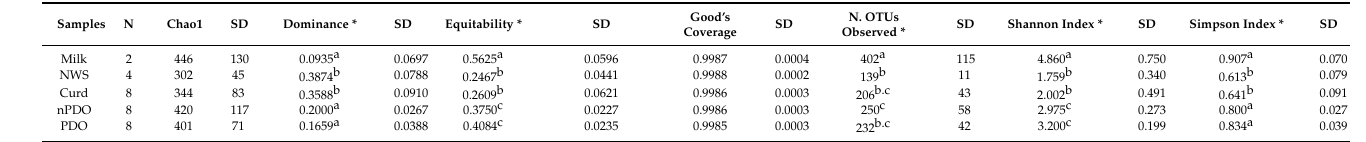
Table 1. Alpha diversity indices observed in samples of raw milk, NWS, curd, non-PDO cheese (nPDO) and PDO cheese (PDO). Values of the mean and standard deviation (SD) are